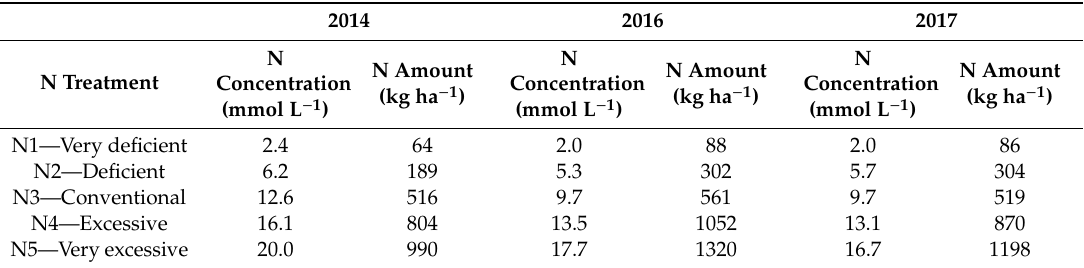
Table 1. Mineral N (NO 3 − –N + NH 4 + –N) concentration in the nutrient solution and mineral N amount applied in fertigation in the three sweet pepper